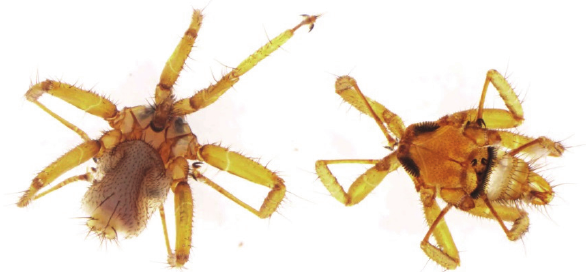
Figure 3. Eucampsipoda africana collected from an Egyptian fruit bat captured in Limpopo Province, South Africa.